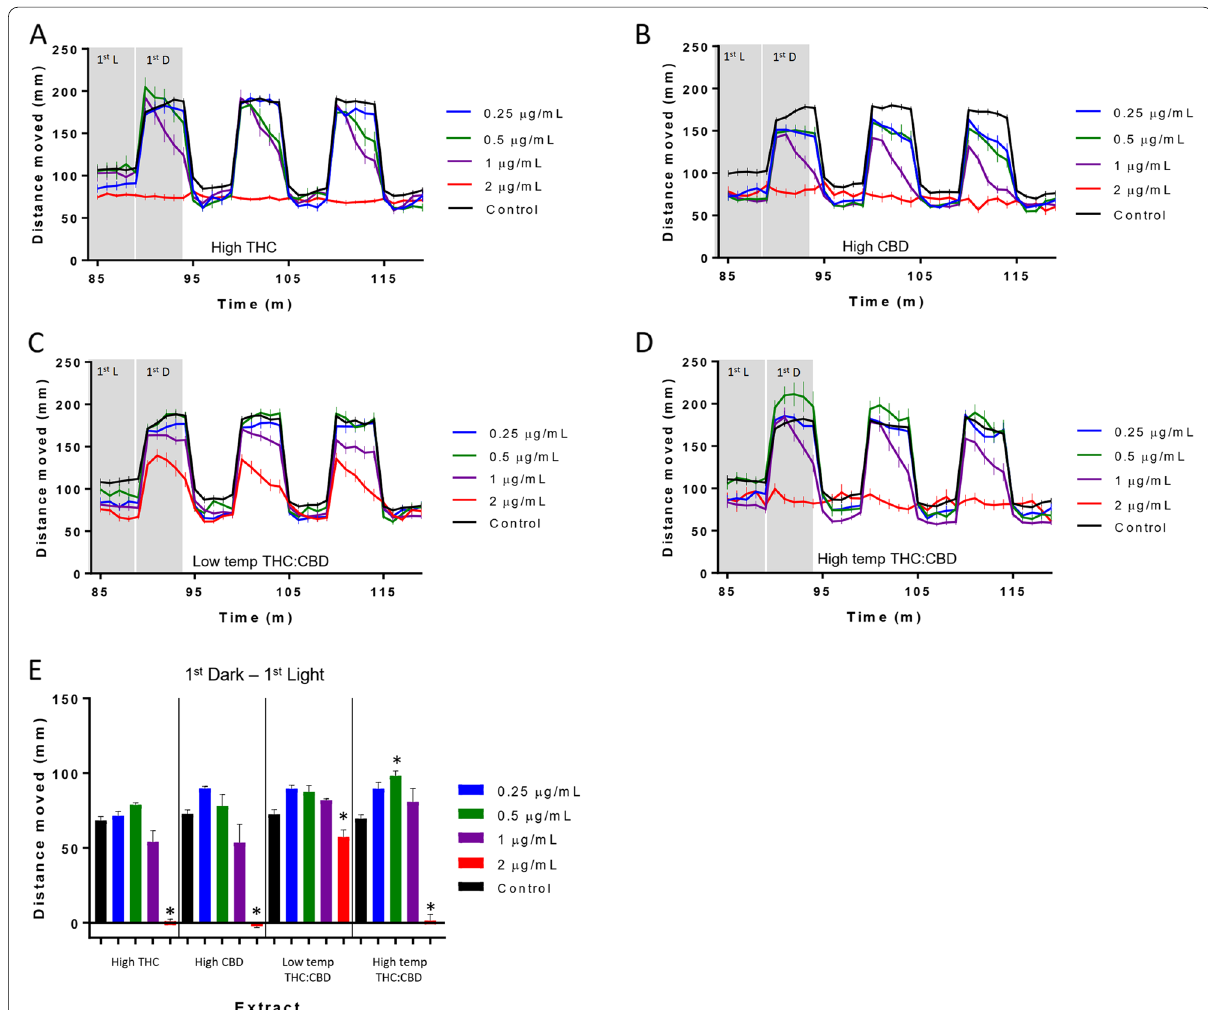
Fig. 2 Larval locomotion following exposure to high THC, high CBD, low‑temp THC:CBD, and high‑temp THC:CBD extracts. A – D Larval behavioral profiles following exposure to extracts at varying concentrations during the alternating 5‑min light/dark cycles. The average distance traveled is presented in millimeters per 1 min bin standard error ( SEM ) and time in minutes. E Difference in the average distance traveled between the ± first 5‑min dark cycle and the preceding 5‑min light. Average distance SEM is presented in millimeters per 5 min bin and time in minutes. Each ± bar represents an n 36 (extract) to 96 (control) larvae. *Significant difference from experimental control as measured by ANOVA followed by a = Bonferroni post hoc test ( p < 0.05)